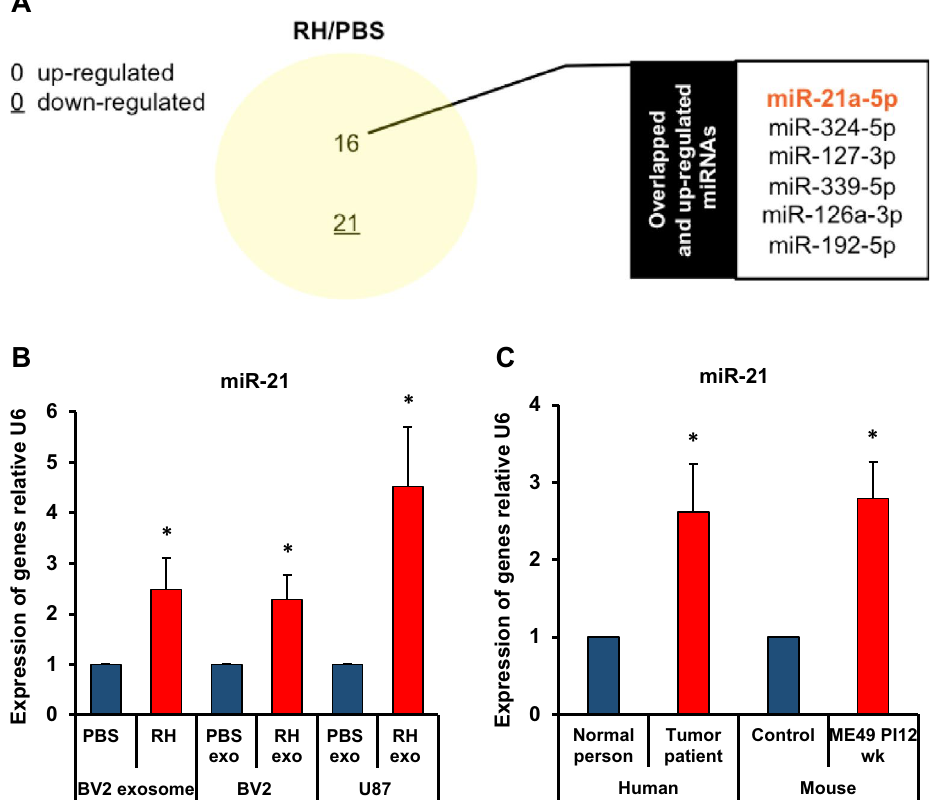
Figure 4. Expression changes of exosomal miR-21a-5p in microglial cells with Toxoplasma (RH) infection. ( A ) It is shown that the immunity or tumor development-related miRNAs were significantly changed in those following the Toxoplasma RH infection. ( B ) The relative expression level of miR-21 was examined in the BV2- derived exosomes, exosomes treated with BV2, and U87 cells by real-time RT-PCR. ( C ) The relative expression level of miR-21 was examined in brain tissue from tumor patients (N = 3) and Toxoplasma (ME49 strain) infected mice (N = 3). * P < 0.05 was obtained by Student’s t test.